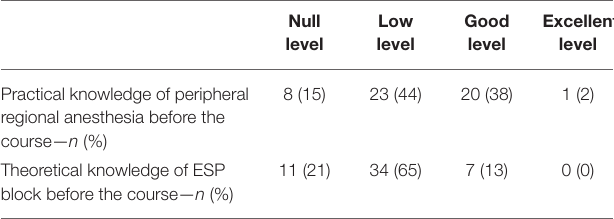
TABLE 1 | Residents questionnaire